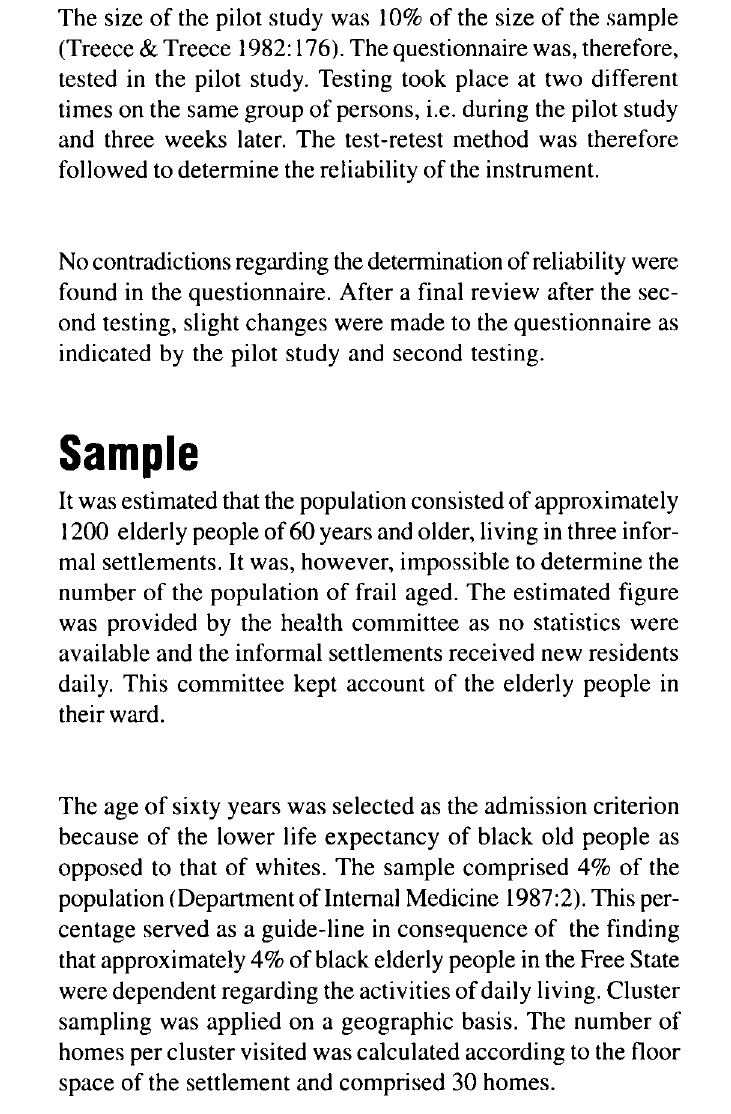
FIGURE 1:Complaints voiced by the elderly regarding different body